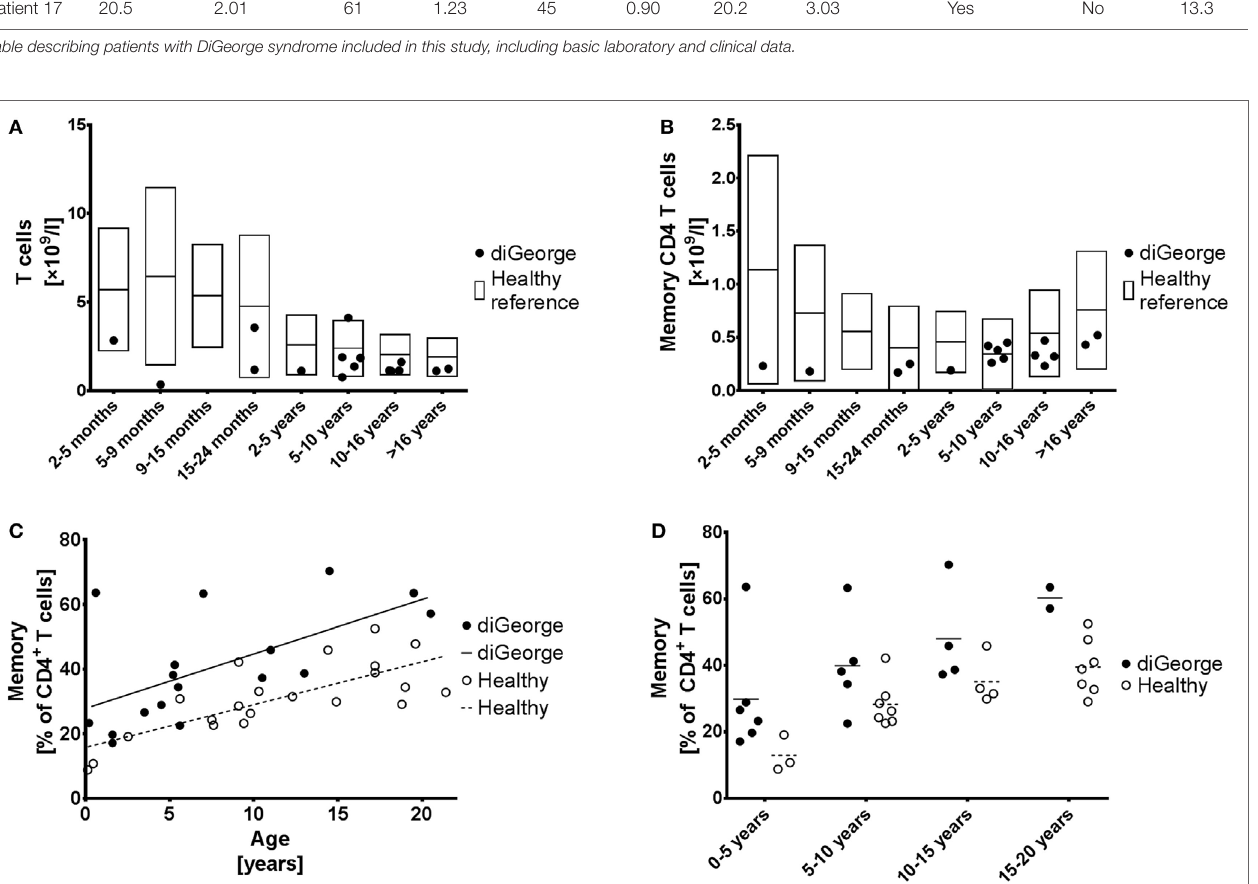
FigUre 1 | Memory CD4 + T cells. (a) Absolute T cell numbers and (b) absolute memory CD4 + T cell numbers in patients with DiGeorge syndrome, compared to published healthy reference values (20), shown as mean and 90% range. (c) Proportion of memory CD4 + T cells of all CD4 + T cells compared to age, shown with linear regression trendlines and (D) divided into several age groups.